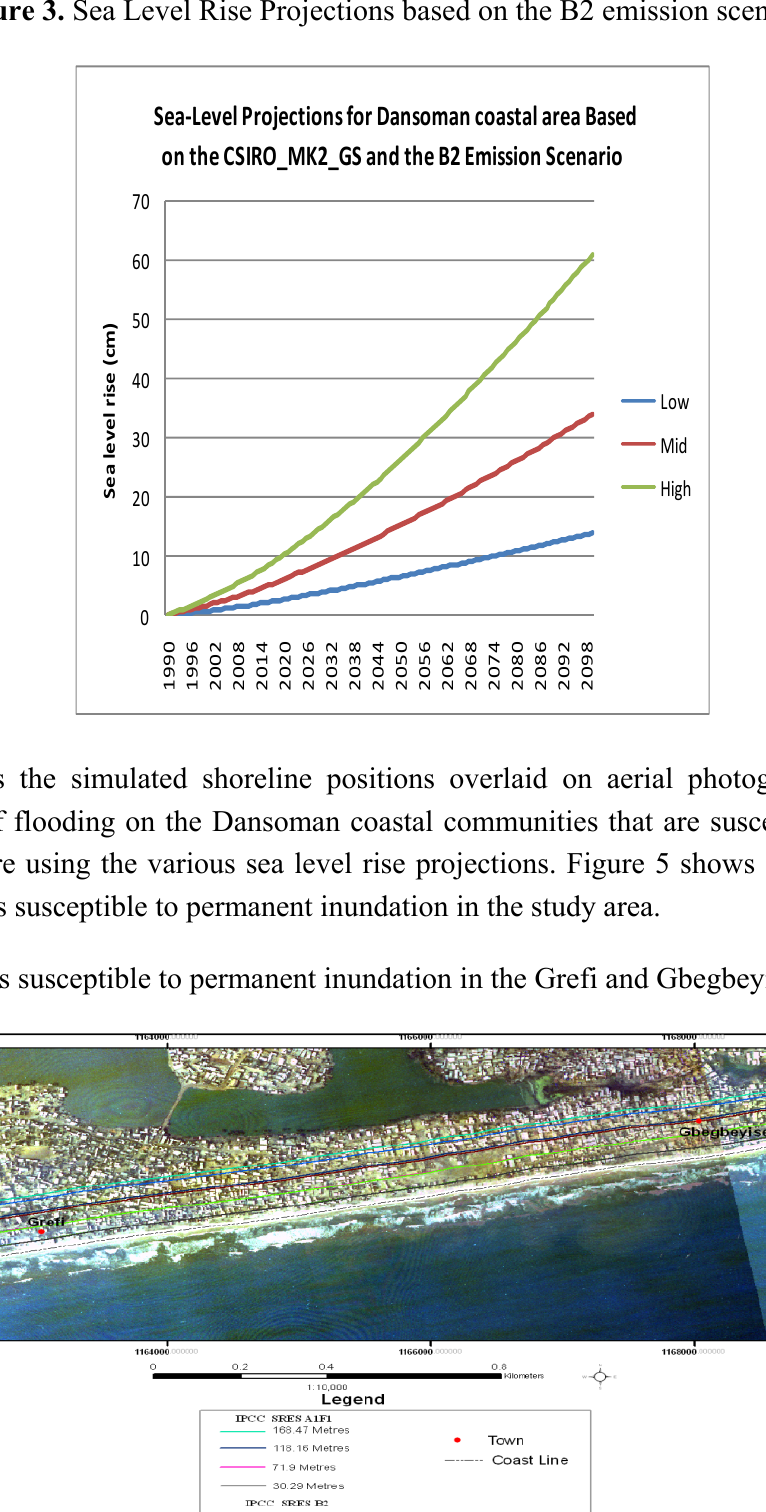
Figure 3. Sea Level Rise Projections based on the B2 emission scenarios.